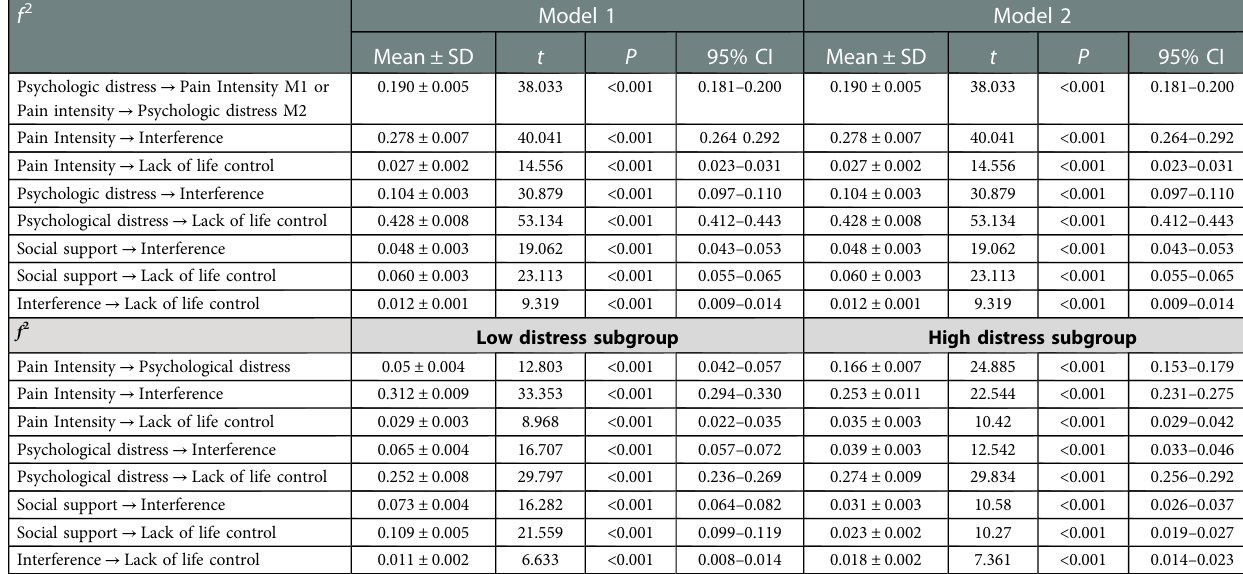
TABLE 5 F-square values ( f 2 ) for the total cohort (model 1 and 2) ( N =40,184) and for the two subgroups Low distress ( N =20,986) and high distress ( N =19,288). Mean±SD, t -values, P -values, and 95% con fi dence intervals (95% CI) are